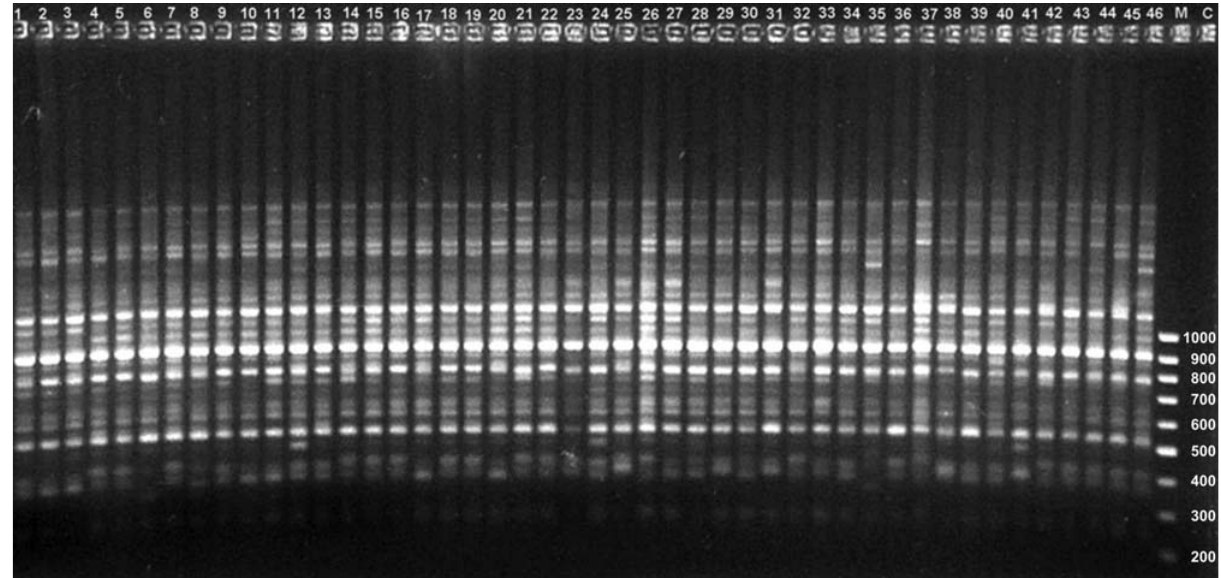
Figure 2 - RAPD profiles, amplified with primer OP-W18, of 46 H. ancistroides collected from sites S1 to S4. Column M, molecular weight marker (Biotools) in bp; Column C, control; columns 1-12, fish collected at site 1; columns 13-23, fish collected at site 2; columns 24-34, fish collected at site 3; columns 35-46, fish collected at site 4.